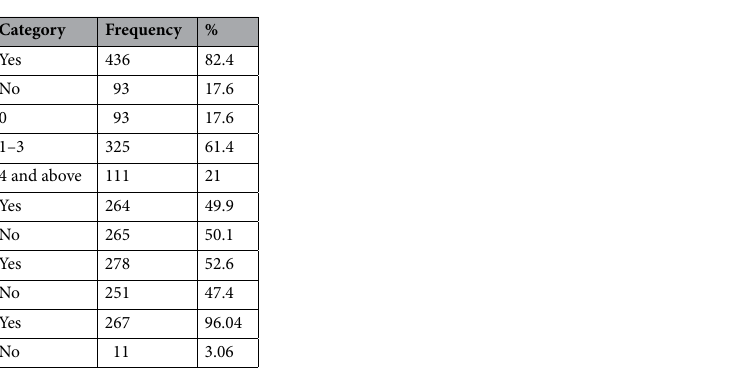
Table 3. Respondent health service utilization in Chereti district, Afderzone, Somali region, southeastern Ethiopia, 2019 (n =